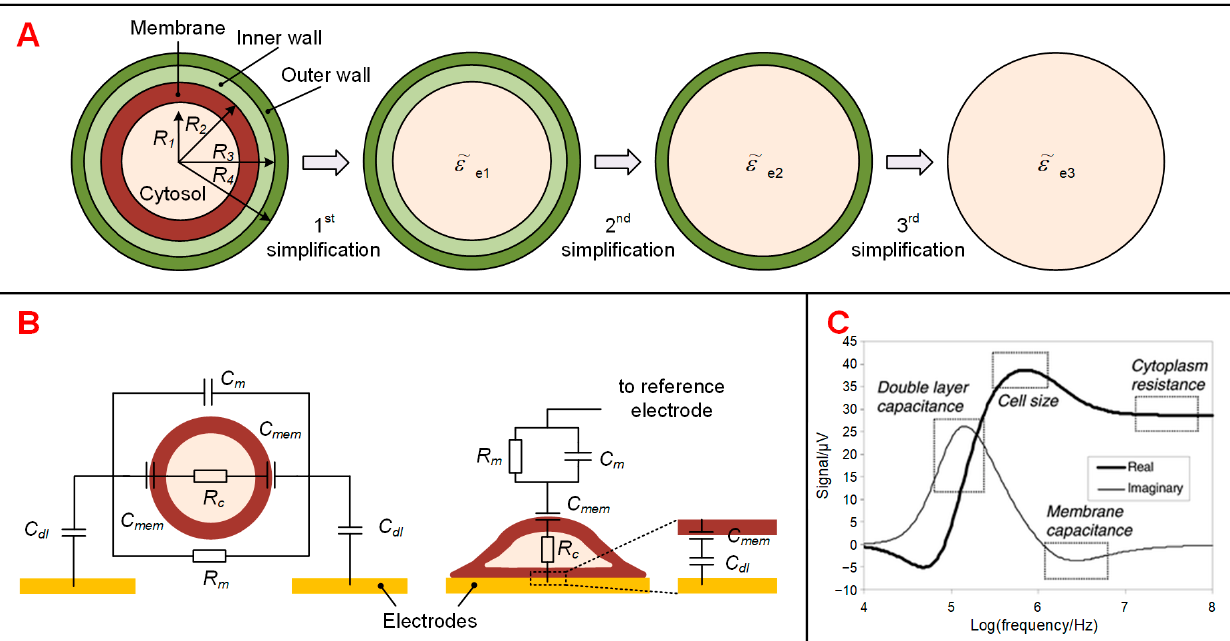
Figure 1. Electrical model and equivalent circuit models (ECMs) of a single cell. ( A ) Multi-shell model of a single cell simplified into a homogeneous sphere based on MMT. ( B ) ECMs of a cell suspended between a pair of sensing electrodes and a cell adhered on a sensing electrode. ( C ) Simulation results of cell impedance sensing using an ECM model, which presented various frequency domains corresponding to different biophysical parameters. Reproduced from [32] with the permission from Royal Society of Chemistry.